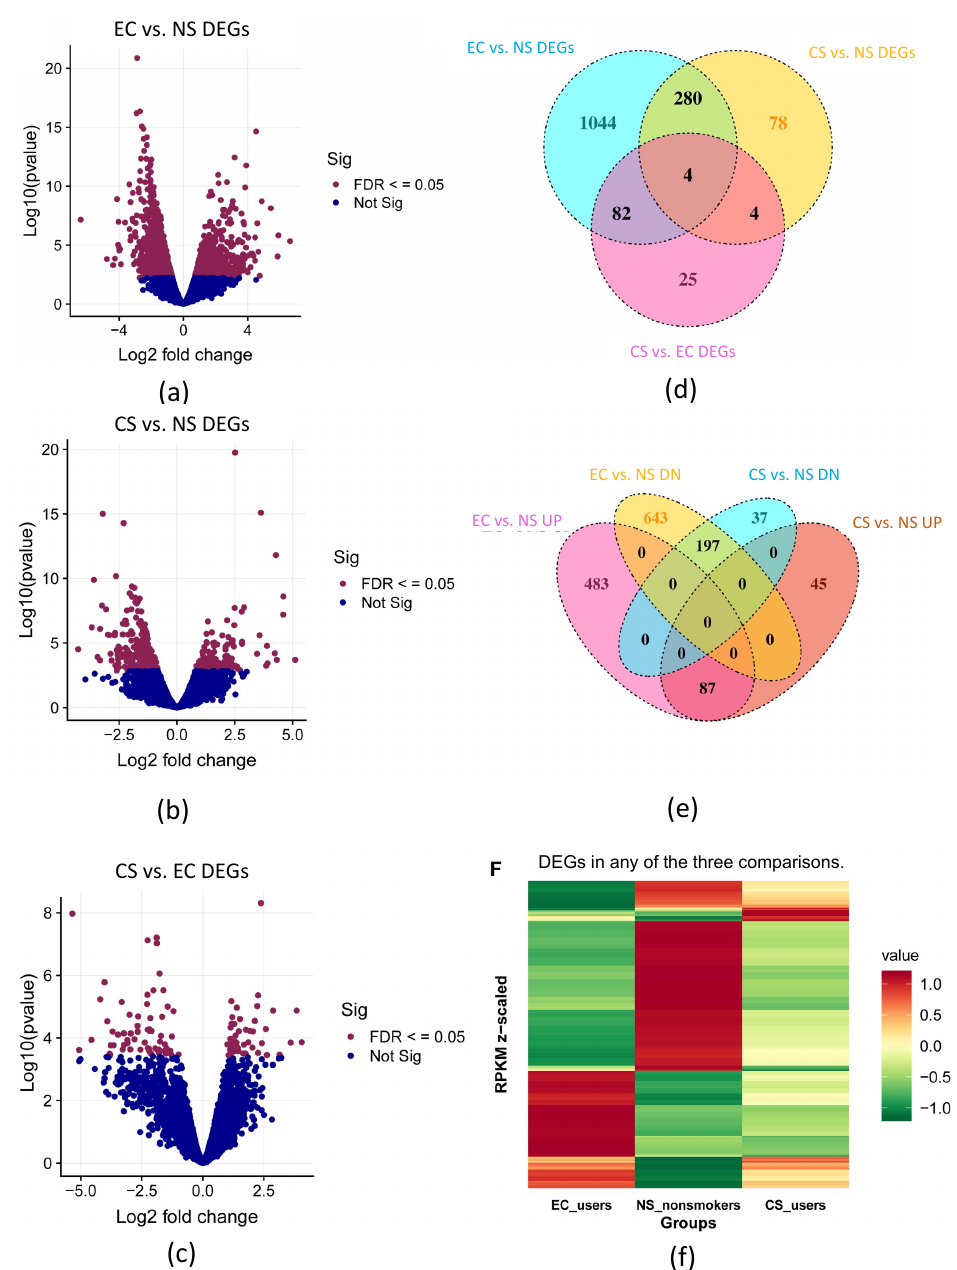
Figure 1. Differential gene expression in the EC, NS, and CS groups. Volcano plots showing DEGs (red dots) in ( a ) EC vs. NS, ( b ) CS vs. NS, ( c ) CS vs. EC sets (FDR < 0.05). ( d ) Venn diagram showing all the DEGs in the EC, NS and CS groups. ( e ) Venn diagram comparing the up and downregulated DEGs (FDR < 0.05) in the EC vs. NS, CS vs. NS, CS vs. EC sets. ( f ) Heatmap showing the RPKM Z-scores for the DEGs that were significant (FDR < 0.05) in any of the three comparisons. Transcripts are different in the three groups, and the EC and NS groups have opposite responses ( f